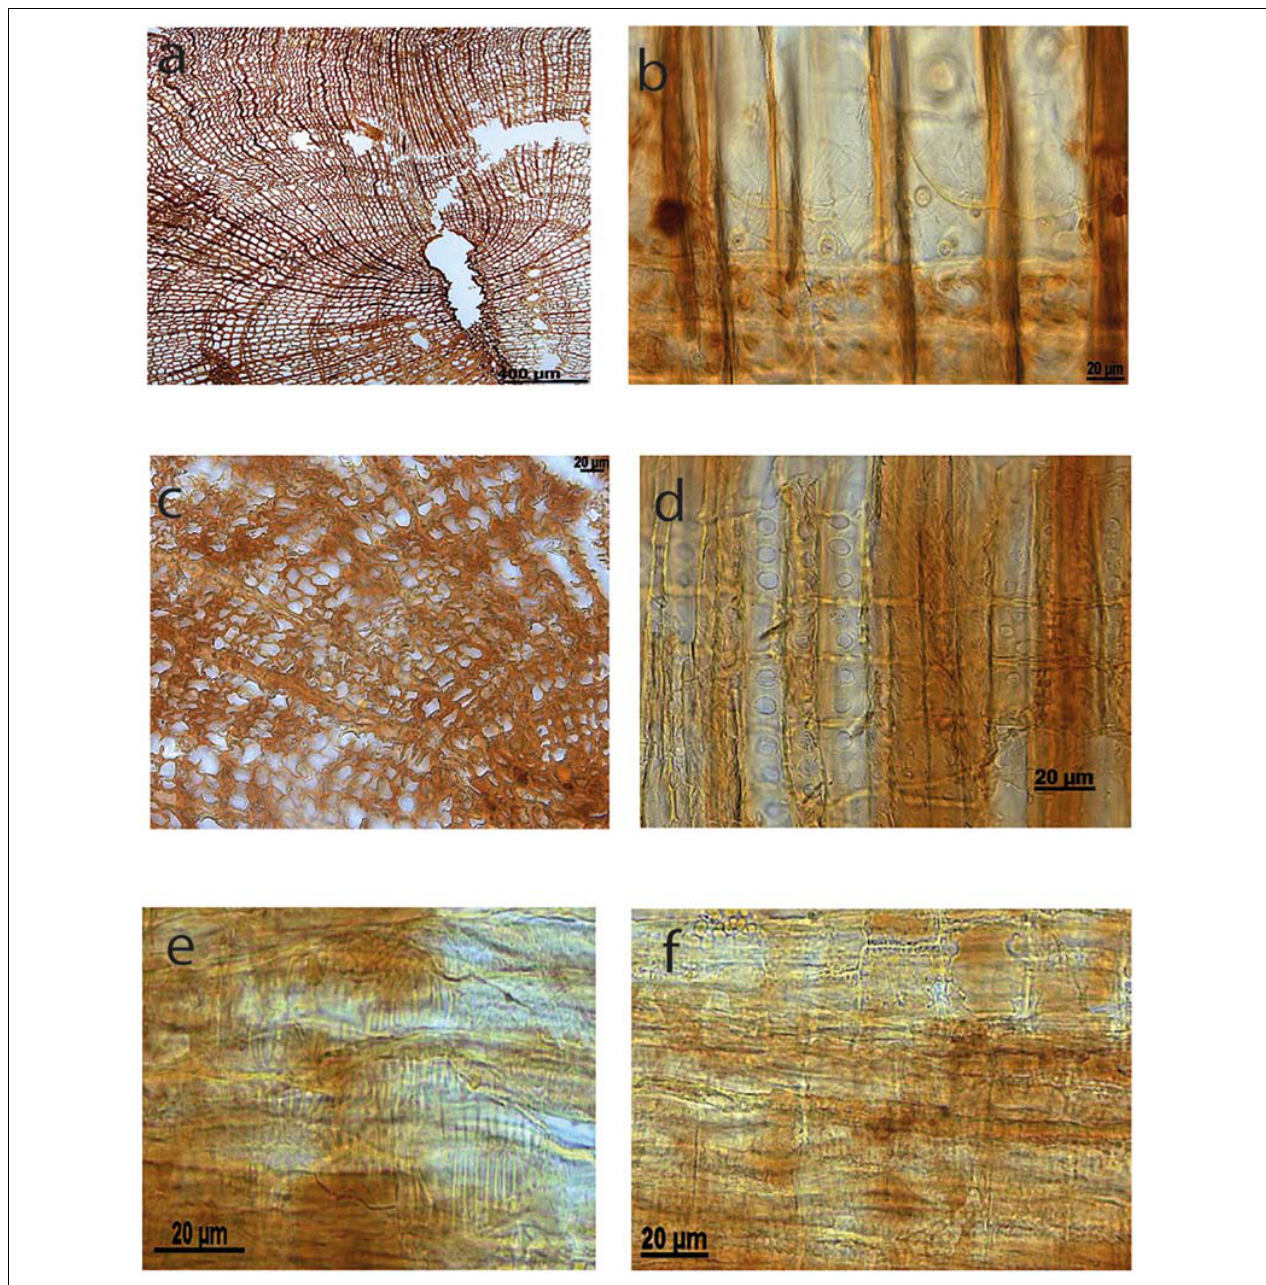
FIGURE 7 | Microtome sections of woody macrofossils found in site 121 sediments: (a) a cross section cut of a Larix sp. root; (b) a radial cut of a Larix sp. root; (c) a cross section cut of an Abies sp. twig; (d) a radial cut of an Abies sp. twig; (e) – a radial cut of an Ericaceae twig; (f) – a cross section cut of an Ericaceae twig. Photos by V.R. Filin (Moscow State University) November